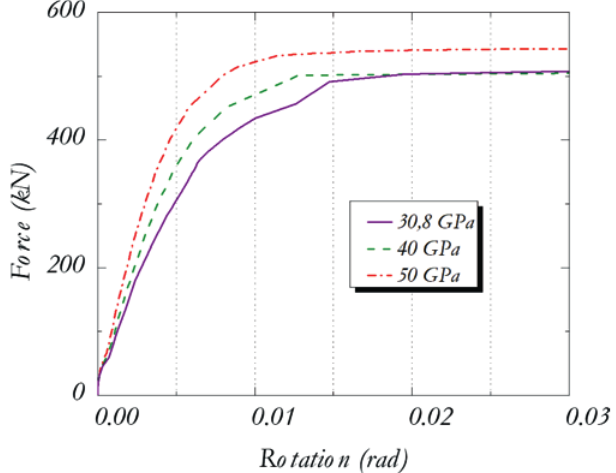
decreases with increase in modulus of elasticity. For 50 GPa, the parameter results negative which has no physical meaning.